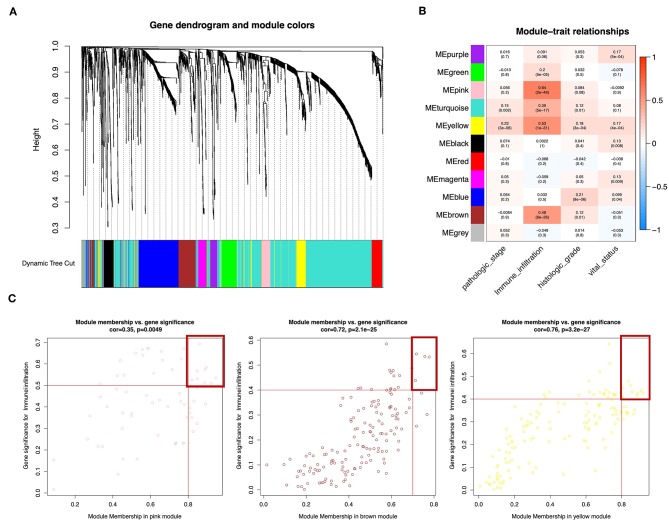
Weighted gene co-expression network of bladder urothelial cancer. (A) Identification of a co-expression module in bladder urothelial cancer. The branches of the cluster dendrogram correspond to the 11 different gene modules. Each piece of the leaves on the cluster dendrogram corresponds to a gene. (B) Correlations between the gene module and clinical traits. The correlation coefficient in each cell represents the correlation between the gene module and the clinical traits, which decreased in size from red to blue. The corresponding P-values are also shown. (C) Scatter plot of module eigengenes in pink, brown, and yellow modules. The red line indicates the screening threshold. The burgundy box identifies the key genes for each module.